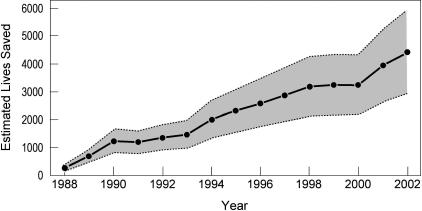
Estimated Number of Lives Saved Since 1988–2002 with the Advent of SSRIsData are shown as a posterior median prediction with 95% Bayesian credible intervals.